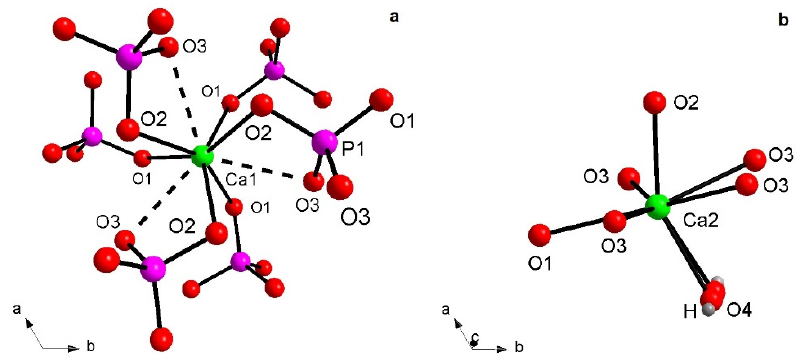
Figure 2. Detail of Ca1 ( a ) and Ca2 ( b ) coordination environments. Table 5. Bond distances (Å), and bond valence parameters for HAp samples. Bond valence sums (in bold) are calculated taking into account 9 bvp values for Ca1, 7 bvp values for Ca2, and 4 bvp values for